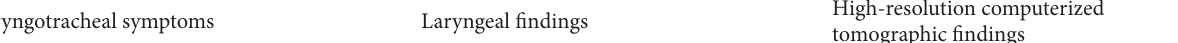
Table 1: Laryngeal manifestations of rheumatoid